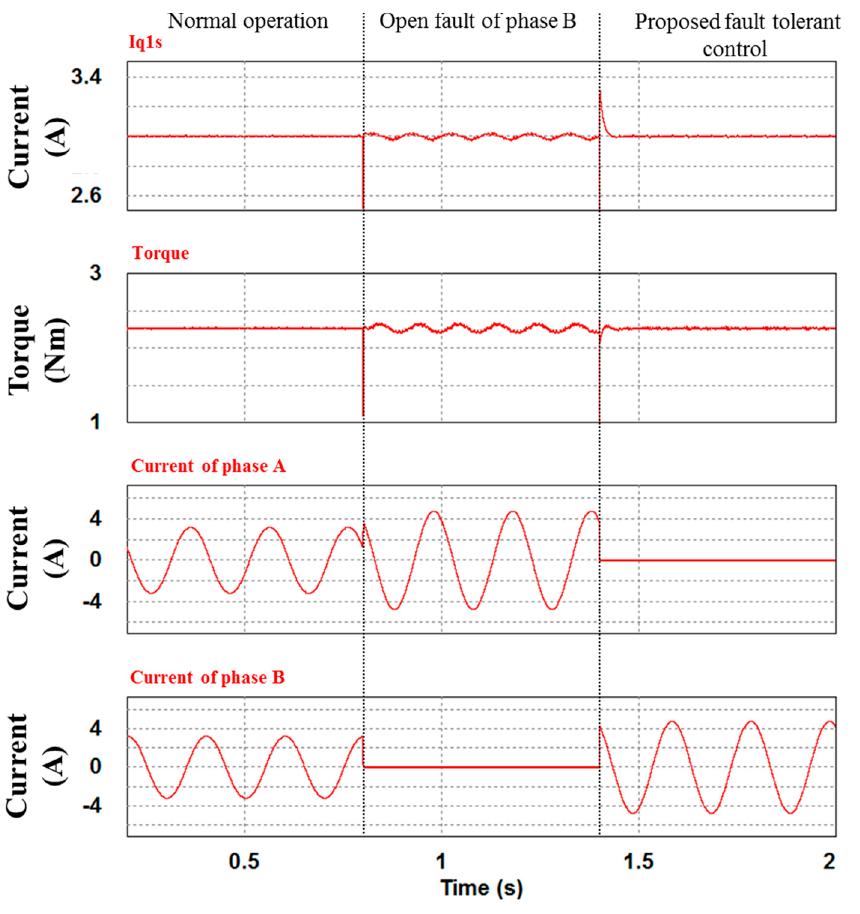
Figure 15. Operation sequence of fault ‐ tolerant control under open fault of phase B.